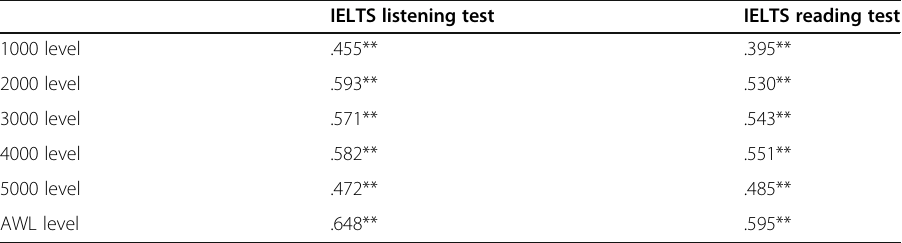
Table 7 Pearson correlations among scores on listening and reading comprehension and different word levels in the LVLT ( N = 234) IELTS listening test